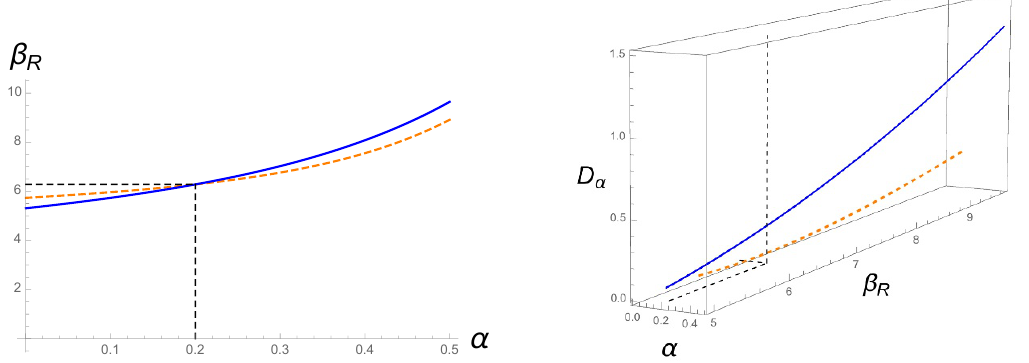
Figure 19 . (Left) Reference inverse temperature (cid:12) R for ( M in ; M out ) (cid:25) (1 : 2 ; 2 : 9) ; (1 : 4 ; 17 : 3) re- spectively in orange dashed and blue, as a function of (cid:11) . The two curves cross at ( (cid:12) R ; (cid:11) ) = (2 (cid:25); 0 : 2). (Right) D (cid:11) ( (cid:26) jj (cid:26) R ) for the two excited states. The monotonicity constraint (B.51) at ( (cid:12) R ; (cid:11) ) = (2 (cid:25); 0 : 2) therefore forbids transitions from the state ( M in ; M out ) (cid:25) (1 : 2 ; 2 : 9) to that